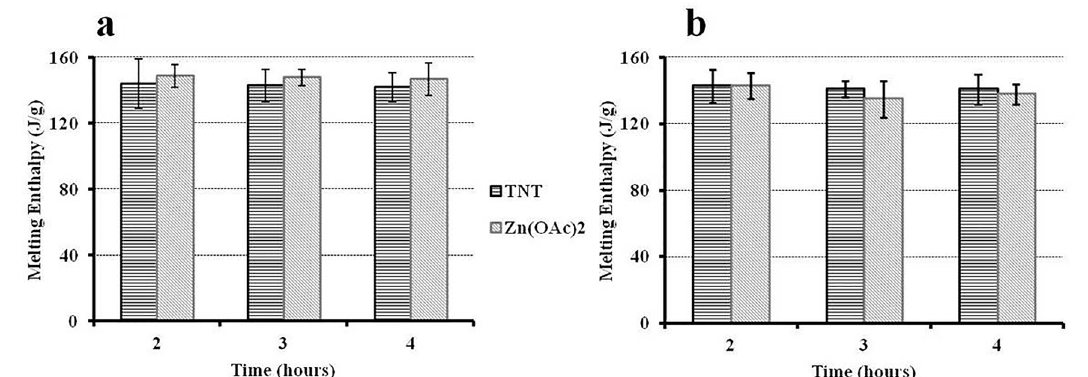
Figure 4. DSC curves of the BHET obtained from: a) virgin PET and b) post-consumer PET.